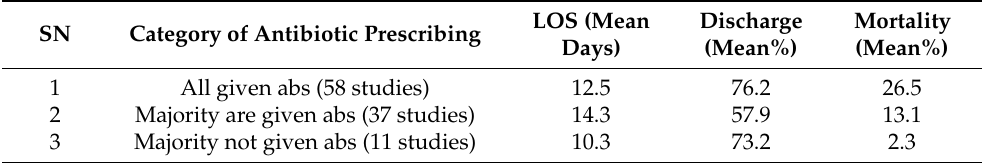
Table 2. Antibiotic prescribing categories and outcomes.